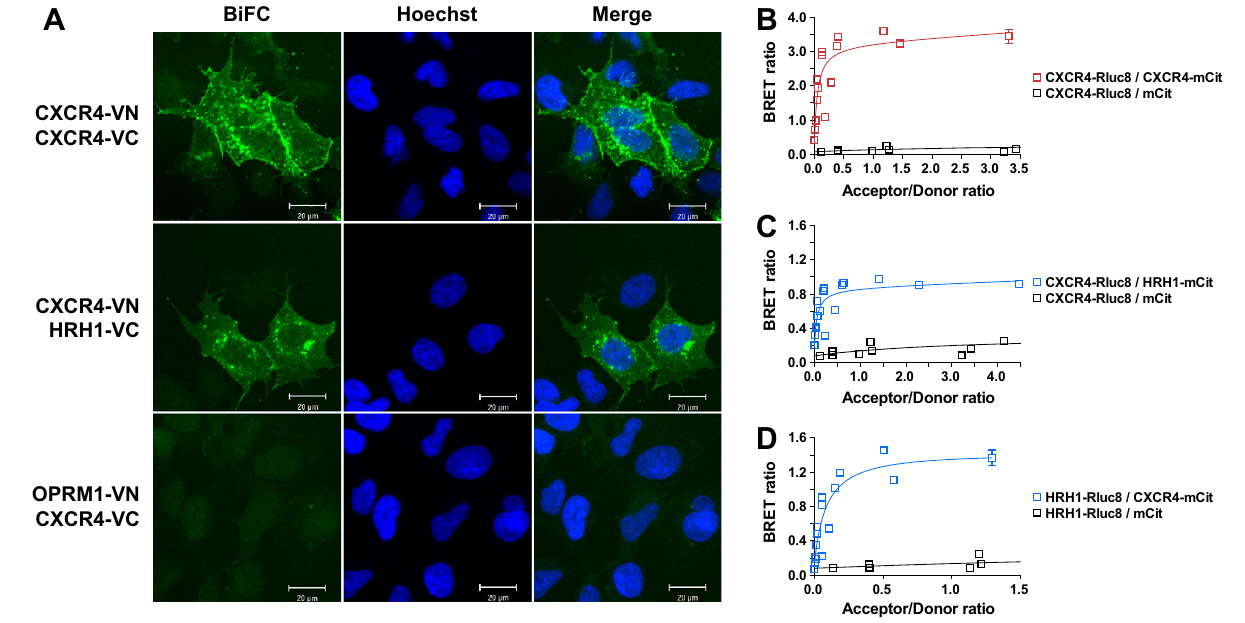
Figure 2. HRH1 physically interacts with CXCR4. ( A ) Analysis of CXCR4-HRH1 heteromerization using the BiFC assay. HEK293A cells were transfected with CXCR4-VN and CXCR4-VC (upper panel), CXCR4-VN and HRH1-VC (middle panel), or OPRM1-VN and CXCR4-VC (lower panel), and BiFC signals were visualized. Cell nuclei were stained with Hoechst 33342. Images are representative of three independent experiments. ( B – D ) Analysis of CXCR4-HRH1 heteromerization using the BRET donor saturation assay. BRET donor saturation curves of CXCR4 homomer ( B ) and CXCR4-HRH1 heteromer ( C , D ) were obtained with HEK293A